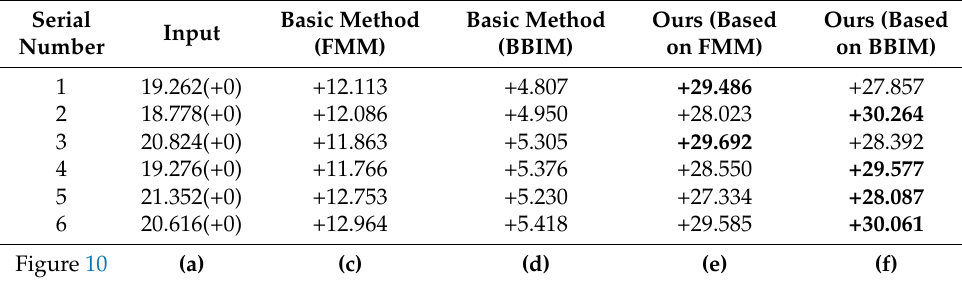
Table 3. Depth image PSNR results.